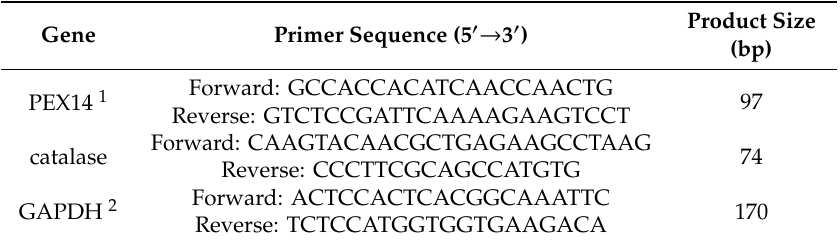
Table 1. Primers used for quantitative real-time